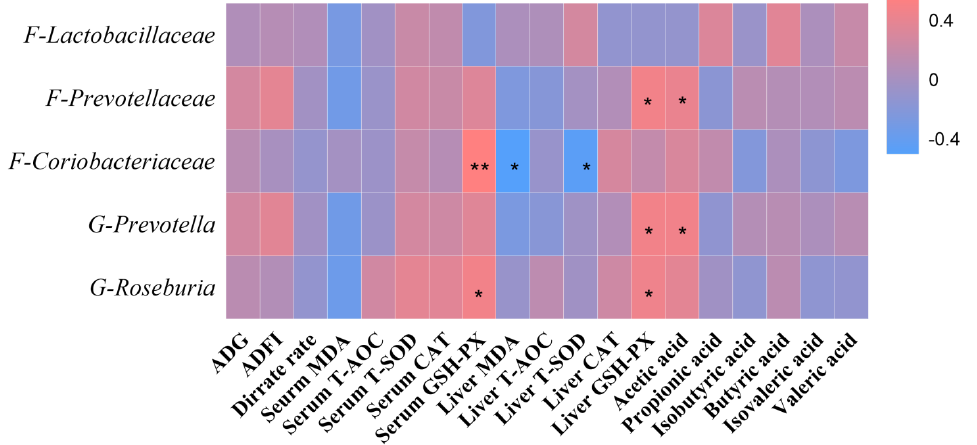
Figure 4. Spearman ’ s correlation was used to measure the correlation of colon microbes with the short-chain fatty acid content of colon contents, 1 − 42 day production performance, serum antioxi- dant capacity, and liver antioxidant capacity. ADG: average daily gain; ADFI: average daily feed intake; MDA: malondialdehyde; TAOC: malondialdehyde; T − SOD: total superoxide dismutase; CAT: catalase; GSH − Px: glutathione peroxidase. In the heatmap of the correlation coefficient, the red represents positive correlations and the blue represents negative correlations (* presented p < 0.05, ** presented p <